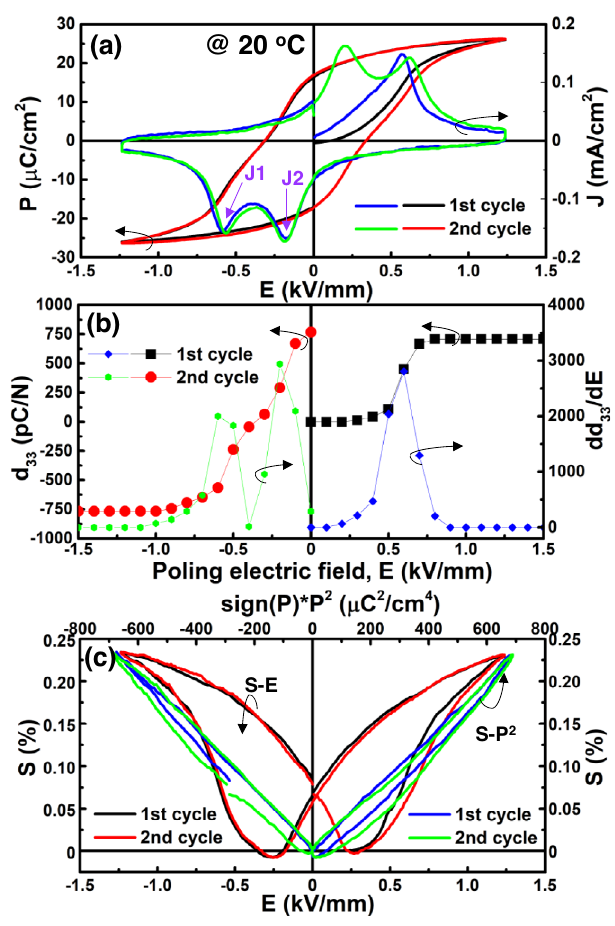
Fig.2|Electricalpropertiesunderbipolarelectric fi eld.a Roomtemperature P-E hysteresis loops and associated J-E curves, b S-E curves and associated S-P 2 curves, and c d 33 -E curvesand associated dd 33 /dE-E curves measured from fi rstand second electriccyclesofPL 8.3 Z 66 T 34 ceramic.Forquasi-static d 33 measurement,thesample was measured at zero fi eld after being poled by a pulse electric fi eld for 1s. Espe- cially for the second-cycle d 33 measurement, the sample was fi rstly poled by an electric fi eld of 1.5kVmm − 1 in the opposite